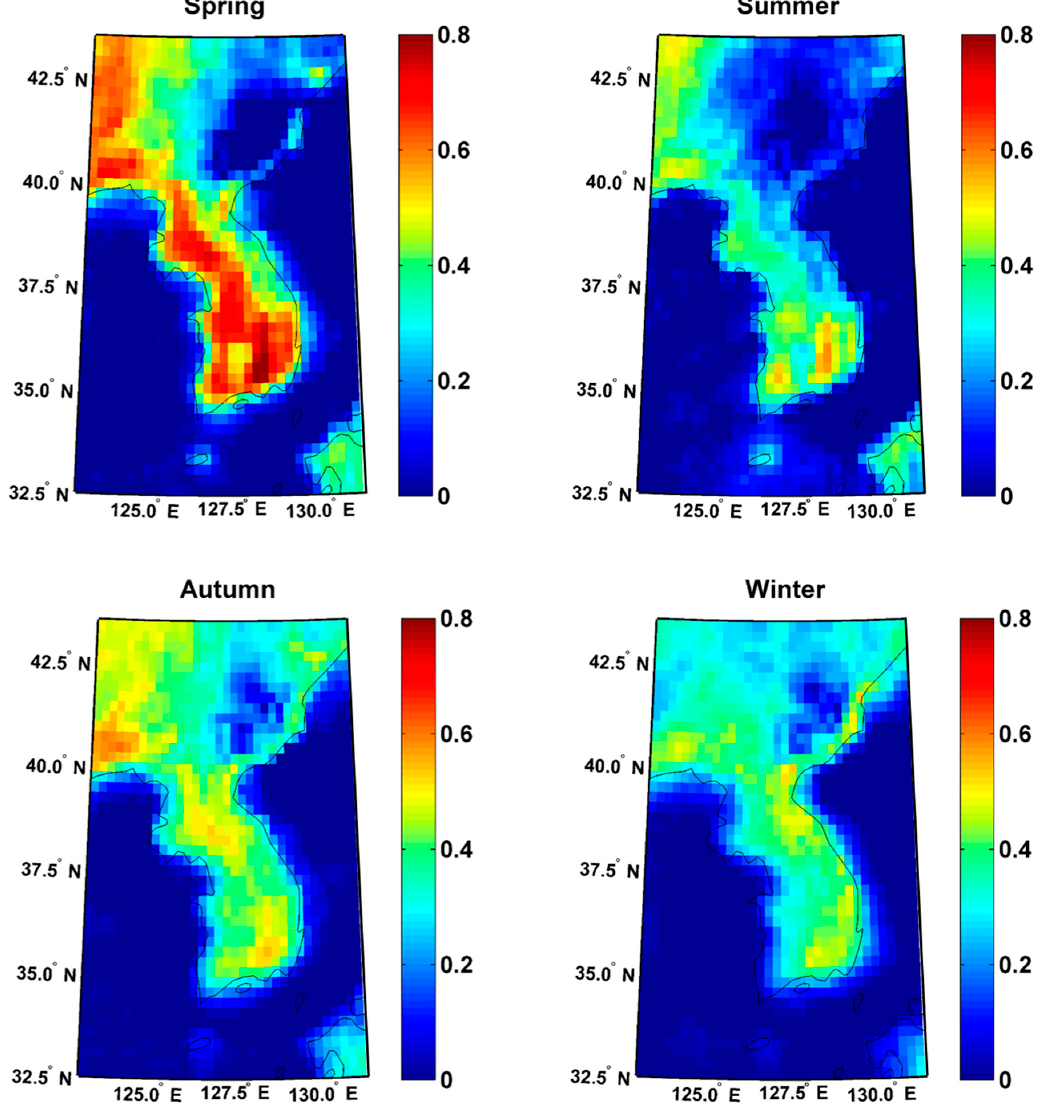
Figure 8. Spatial distribution of average PBLH growth rate from 09:00 LT to 15:00 LT (km/6 h).